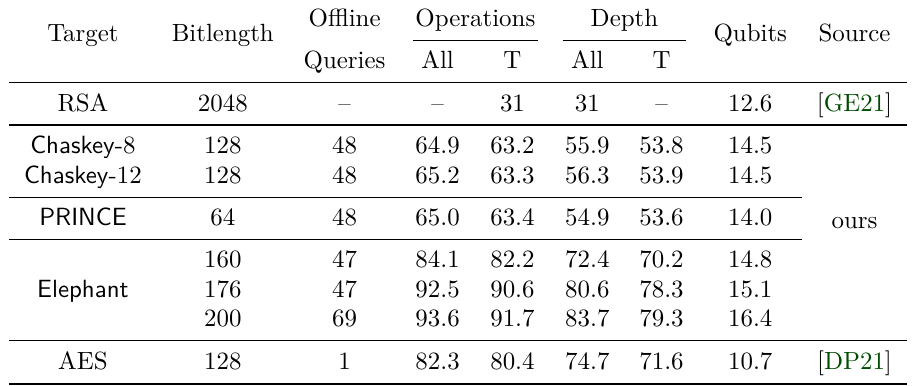
Table 2: Offline Simon attack cost estimates with the recommended query limits, with RSA and AES for comparison. All figures in log base 2 except bitlength.